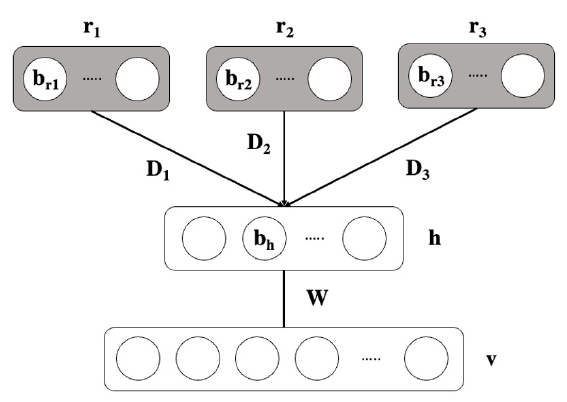
Figure 3. Our proposed M-CRBMs, incorporating three conditional layers that take different types of extra information into account.